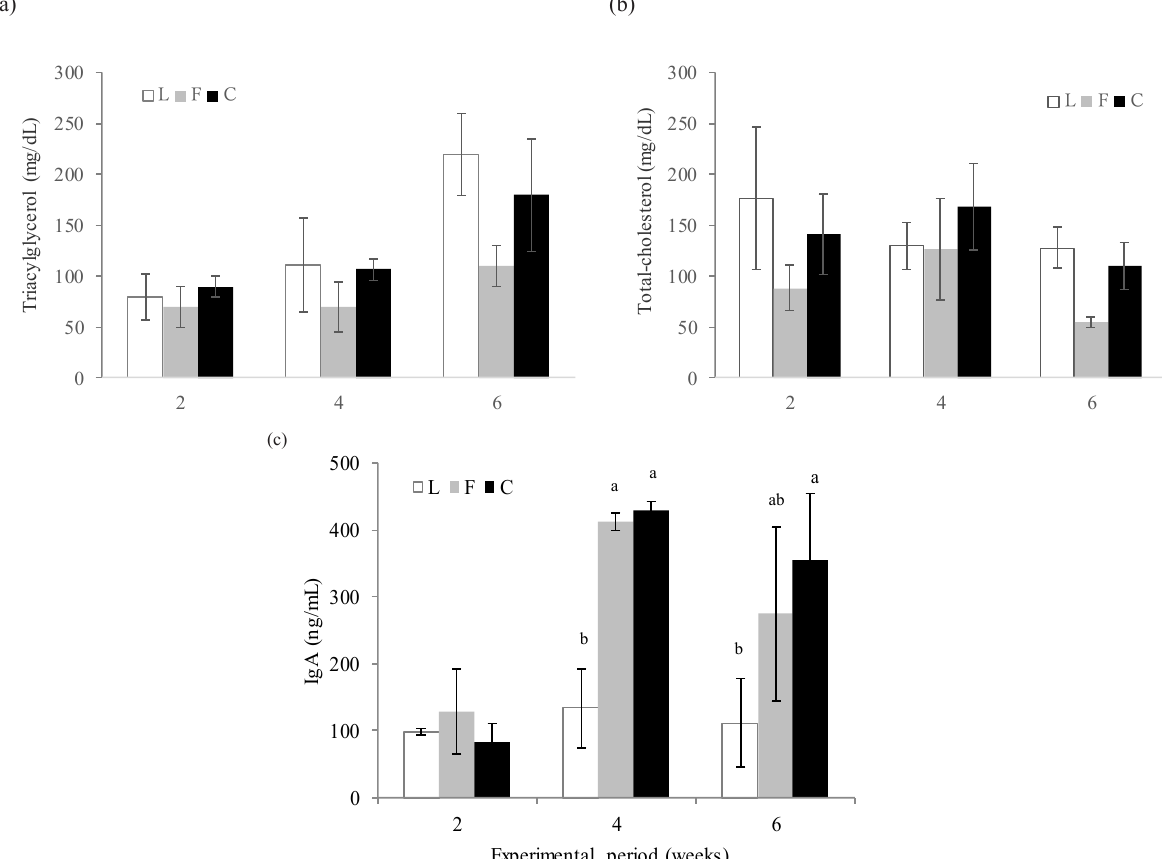
Figure 2: Plasma lipids and IgA levels in mice fed experimental diets. L: lard diet; F: fish oil diet; C: coconut oil diet.Values represent the mean ± SD (n=5). Within a grouping, values not sharing a common superscript letter are significantly different at p < 0.05.